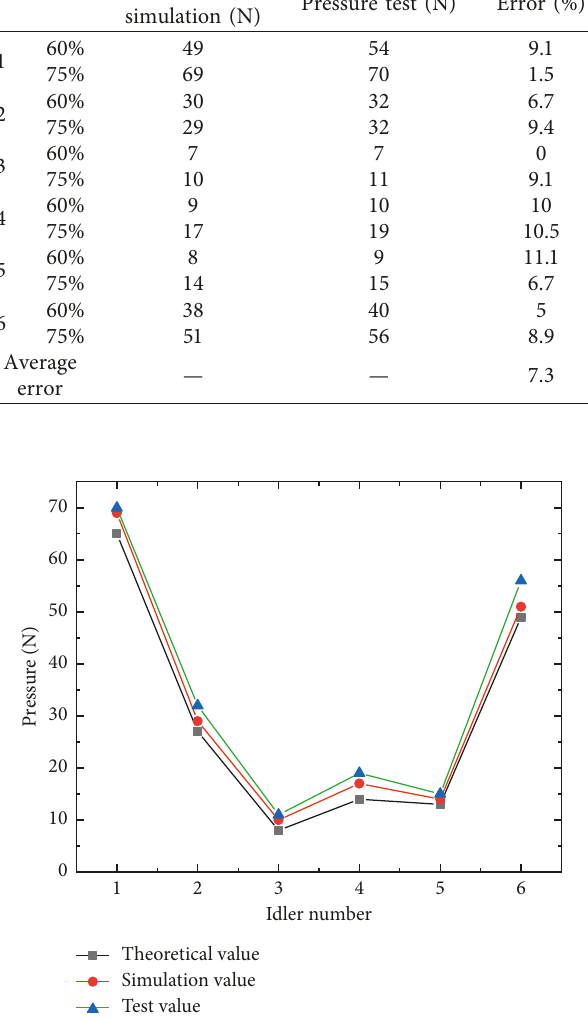
Figure 8: Pressure comparison of theoretical, simulation, and test